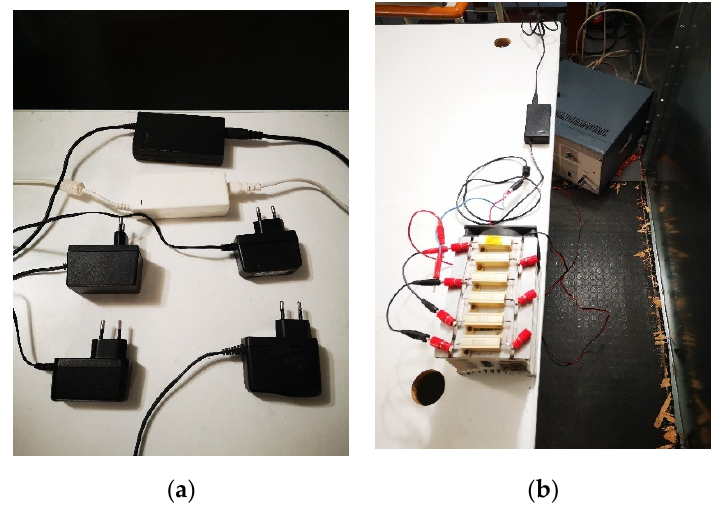
Figure 1. Scheme of the experimental setup: SMPS under test and its DC variable load, LISN (line impedance stabilization network), 50 Ω impedance matching, high-pass filter (1 kHz cutoff) and low-pass filter (2 MHz cutoff), digital storage oscilloscope (DSO) and EMI receiver.